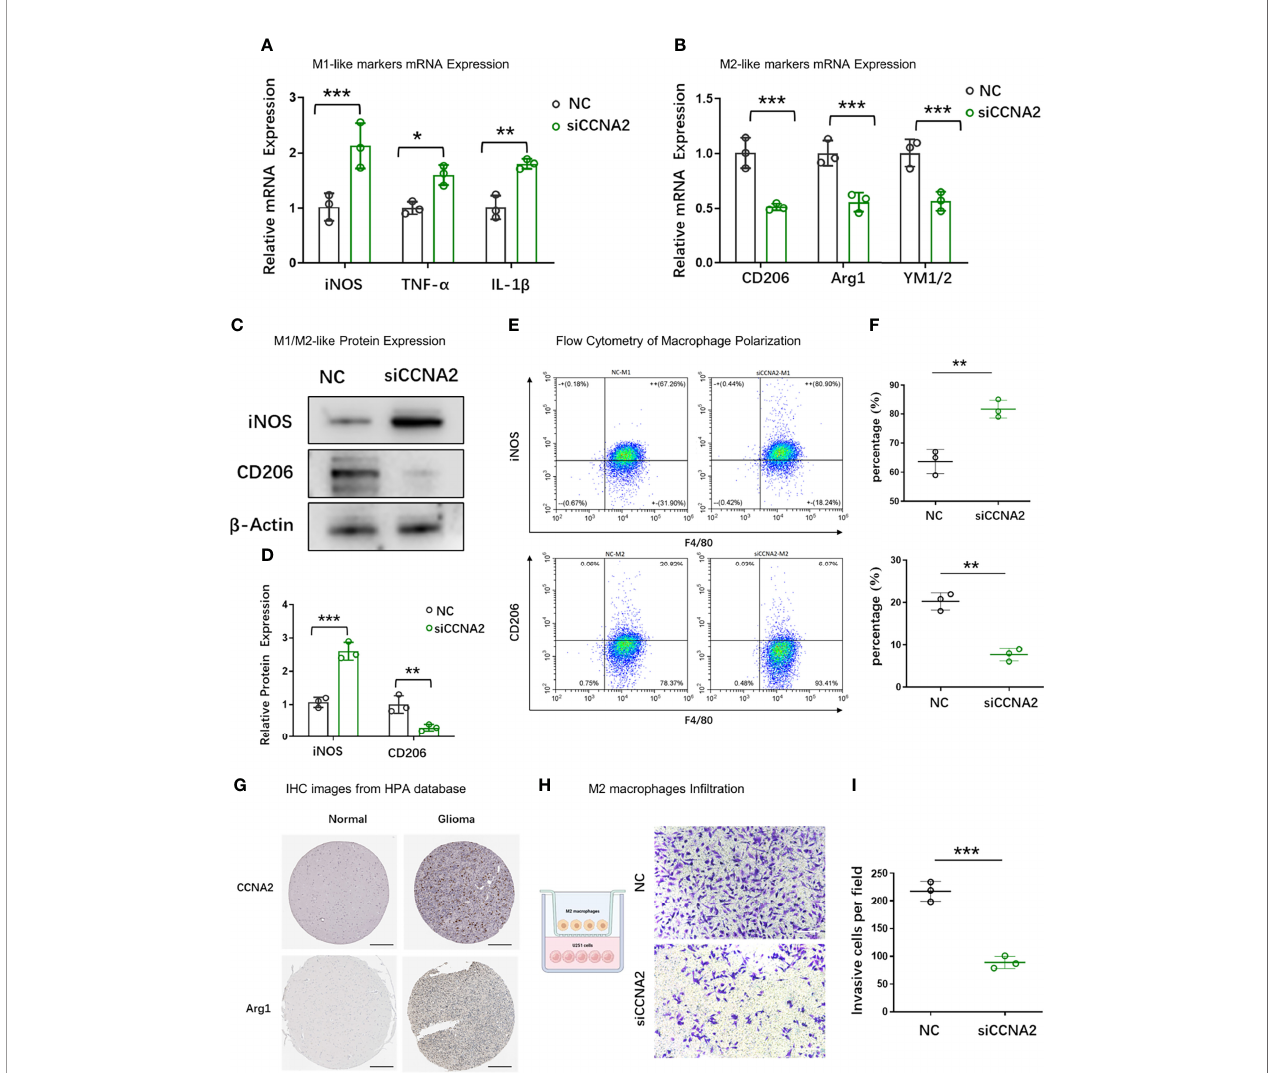
FIGURE 11 | Effect of CCNA2 on macrophage polarization. (A, B) mRNA expression levels of M1-like and M2-like markers of macrophages after co-cultured with U251-siCCNA2 cells and controls. (C, D) Protein levels of iNOS and CD206 of macrophages after co-cultured with transfected cells. (E, F) Flow cytometry analysis of iNOS and CD206 expression in indicated groups. (G) Representative IHC images of CCNA2 and M2-like marker Arg1 in normal brain and glioma tissues from the HPA database. (H, I) M2 macrophage in fi ltration after co-cultured with indicated cells. * P < 0.05, ** P < 0.01, *** P <